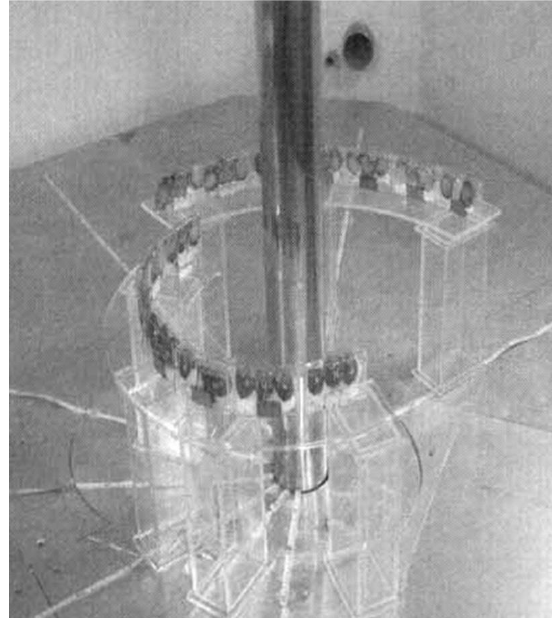
Figure 2. Gamma irradiation in Haliotis diversicolor aquatilis